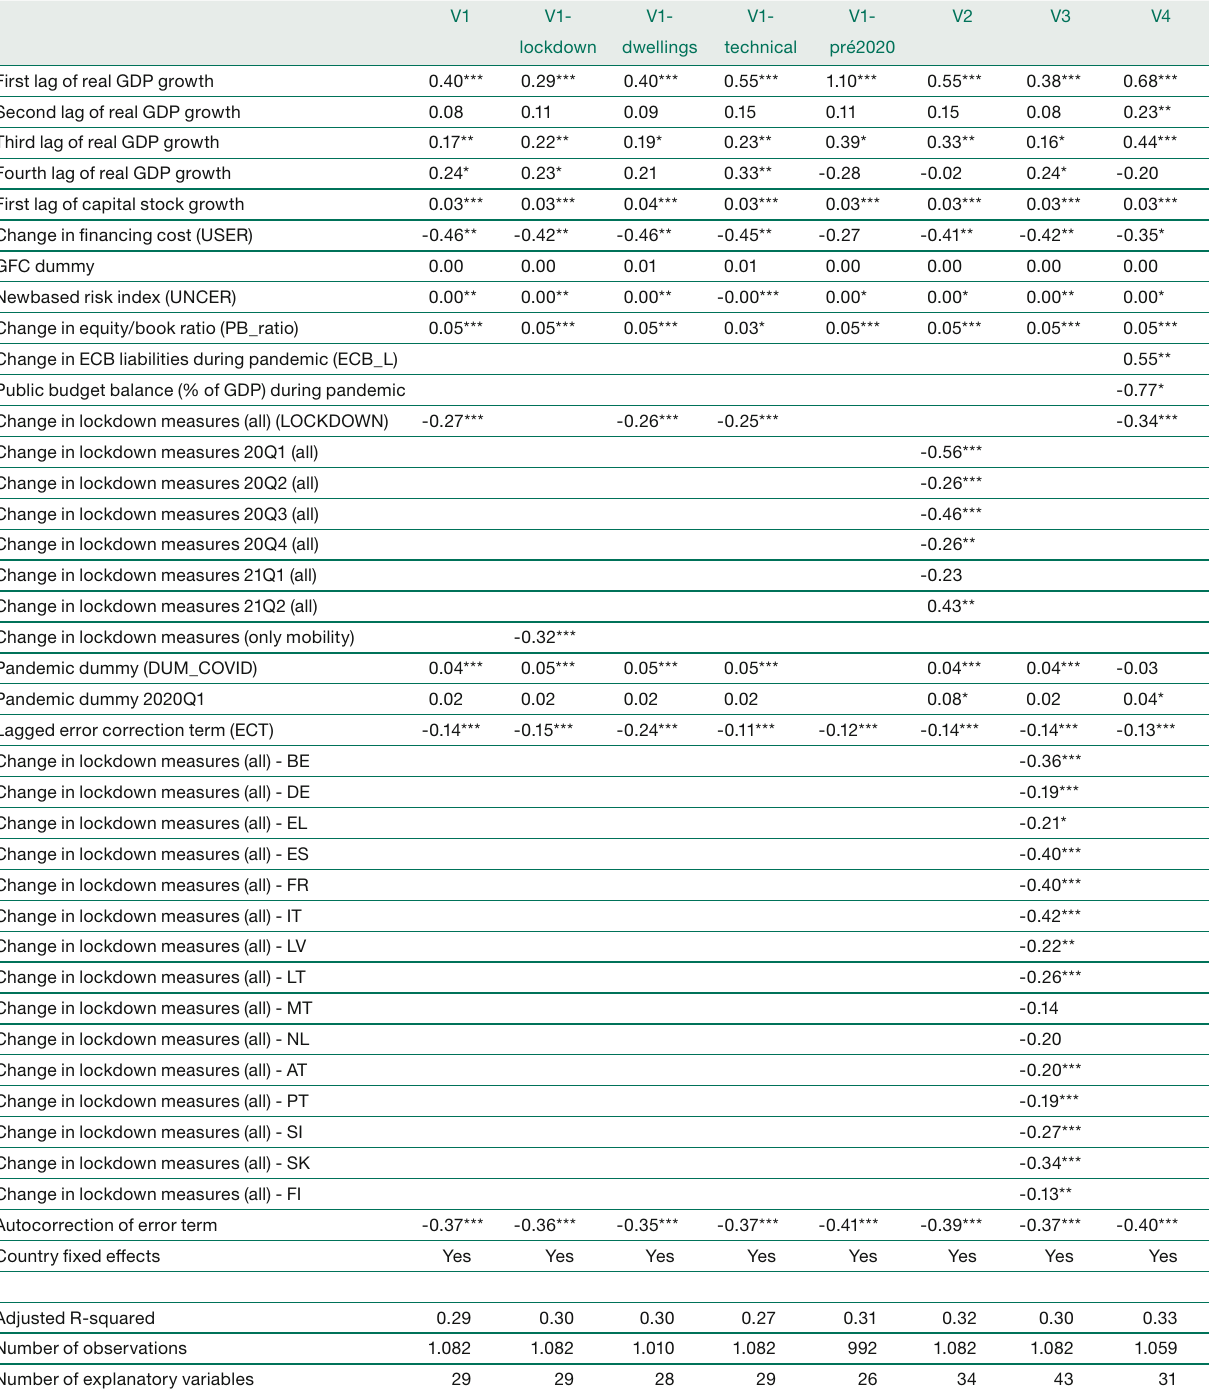
Table 2 Point estimates of the panel error correction